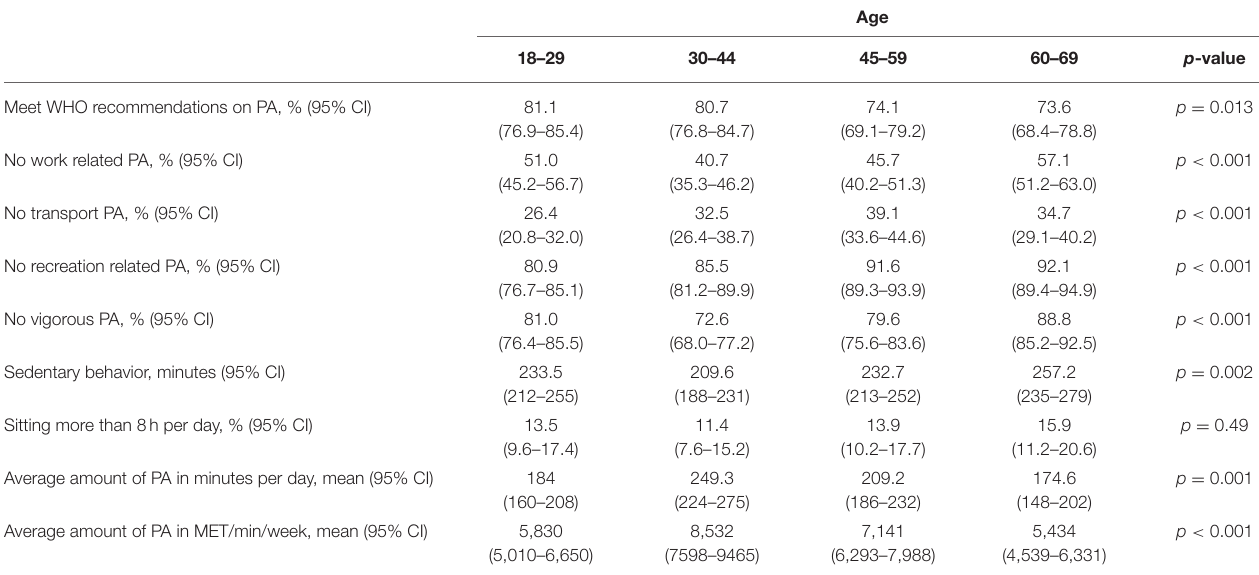
TABLE 3 | Indicators of physical activity and sedentary behavior for